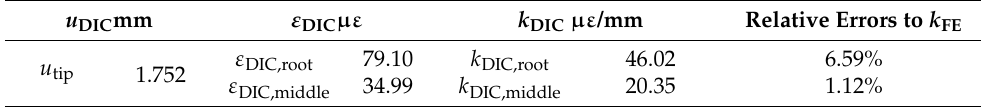
Figure 13. DIC results of interested displacement and strain in frequency domain under a single frequency excitation: ( a ) Blade tip displacement in frequency domain; ( b ) Blade middle and root strain in frequency domain. Table 2. Ratio k from the DIC experiment at the first order of mode frequency.